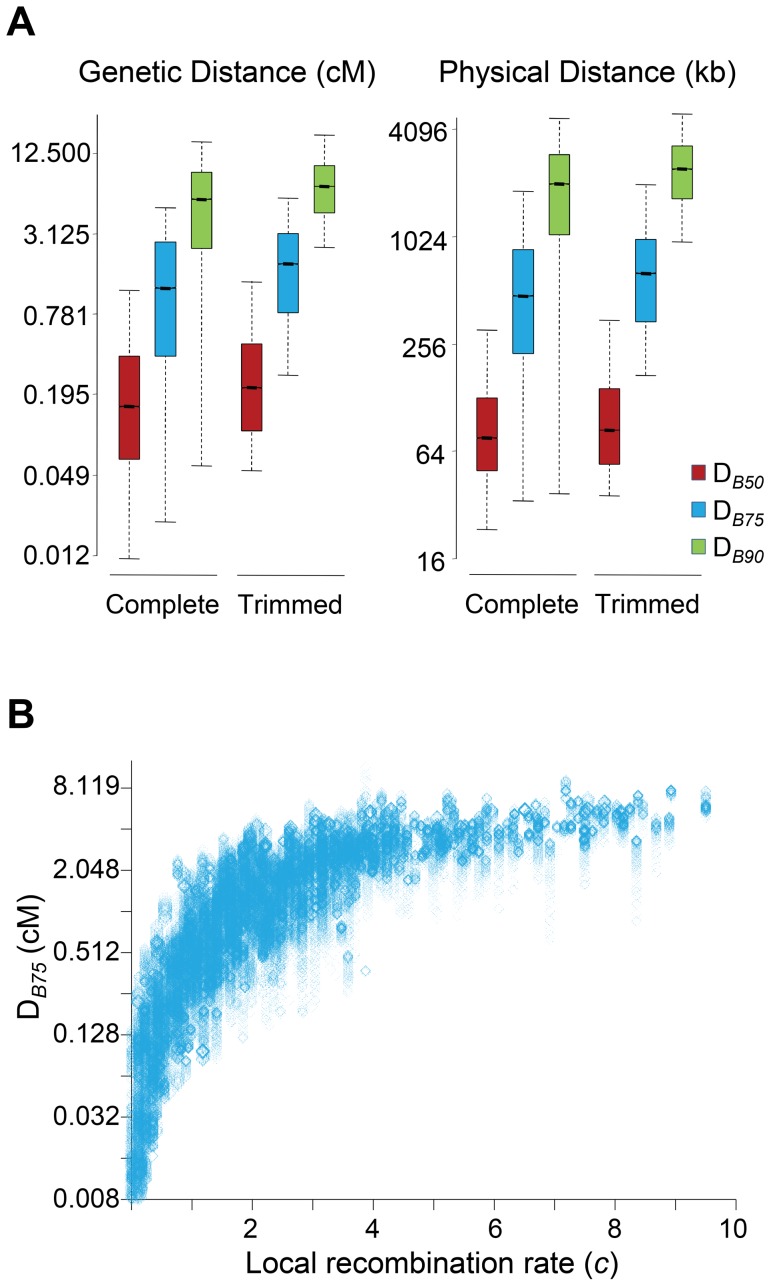
Genomic distance influencing patterns of BGS in D. melanogaster.(A) Boxplots of estimates of DB50, DB75 and DB90. DB90 is defined as the size of the genomic region around a focal point needed to generate 90% of the total BGS effect obtained when considering the whole chromosome. Equivalently, DB75 and DB50 indicate genomic distances needed to generate 75 and 50%, respectively, of the total BGS effect obtained when considering the complete chromosome. The units of DB are genetic distances (cM/female meiosis) or physical distances (kb). (See Figure 1 legend for further explanation of boxplots.) Results shown for the default model MLN,StdMut,CO+GC. (B) Relationship between local recombination rates (c; cM/Mb per female meiosis) and estimates of DB75 in genetic distance. Results shown based on the analysis of 1-kb non-overlapping regions across the whole genome (Spearman's ρ = 0.907, P<1×10−12).